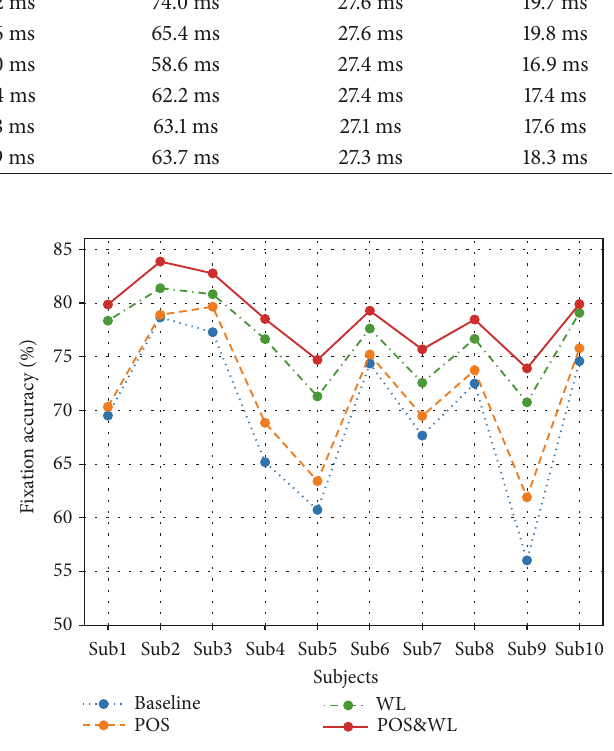
Figure 5: Fixation prediction accuracy comparison using different features on the validation